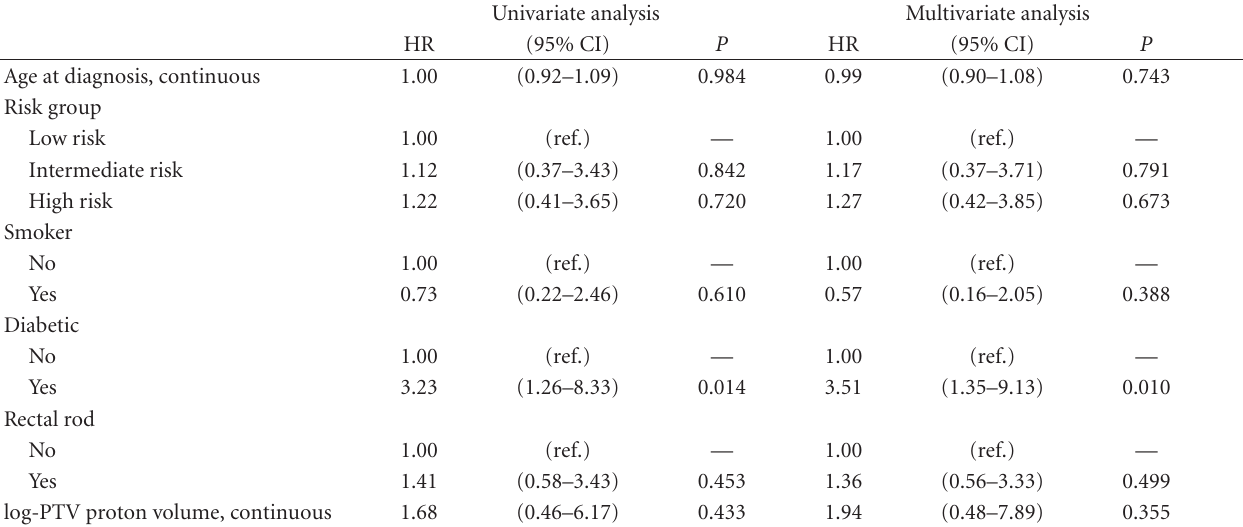
Figure 5: Cumulative probability of a gastrointestinal (GI) event of a given grade in patients with a baseline GI grade = 0 (panel a). Numbers of patients at risk are shown at di ff erent time intervals. (Panel b) illustrates the actuarial prevalence of a given GI grade in the same group. Table 6: Cox regression model—GI grade 2 or higher ∗